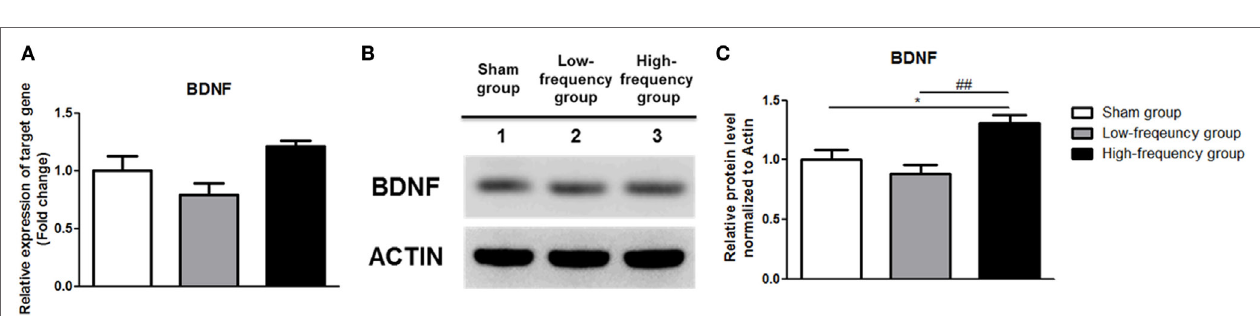
FigUre 4 | Repetitive magnetic stimulation treatment increased brain-derived neurotrophic factor (BDNF) expression in undifferentiated Neuro-2a cells. (a) The relative mRNA expression of BDNF was normalized by sham expression and was calculated using the 2 −ΔΔ Ct method by qRT-PCR. All results are expressed as means ± SEM. (B) Western blot analysis was performed using antibodies against BDNF, and actin (a control). (c) Comparison of relative protein expression for BDNF and actin (a control) with Multi Guage (v3.0) software (Fujifilm). All results are expressed as means ± SEM. *** p < 0.001 comparison with the sham group in undifferentiated Neuro-2a cells. ### p < 0.001 comparison with the low-frequency group in undifferentiated Neuro-2a cells.